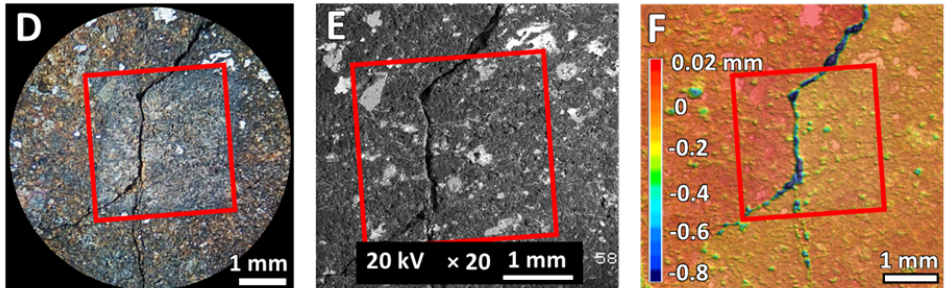
Figure 9. Ablation site for the Bivoj laser (ablation of the chondritic meteorite SaU 567 in air, 10 shots accumulated in one spot) examined by optical microscopy ( panel A , white dashed square defines the singed areas around the spot), scanning electron microscopy ( panel B ), and optical profilometry ( panel C ). Ablation site for the Bivoj laser (ablation of the chondritic meteorite SaU 567 under water, 1 shot) examined by optical microscopy ( panel D ), scanning electron microscopy ( panel E ), and optical profilometry ( panel F ). The length of the spot’s edge is about 3.1 mm.